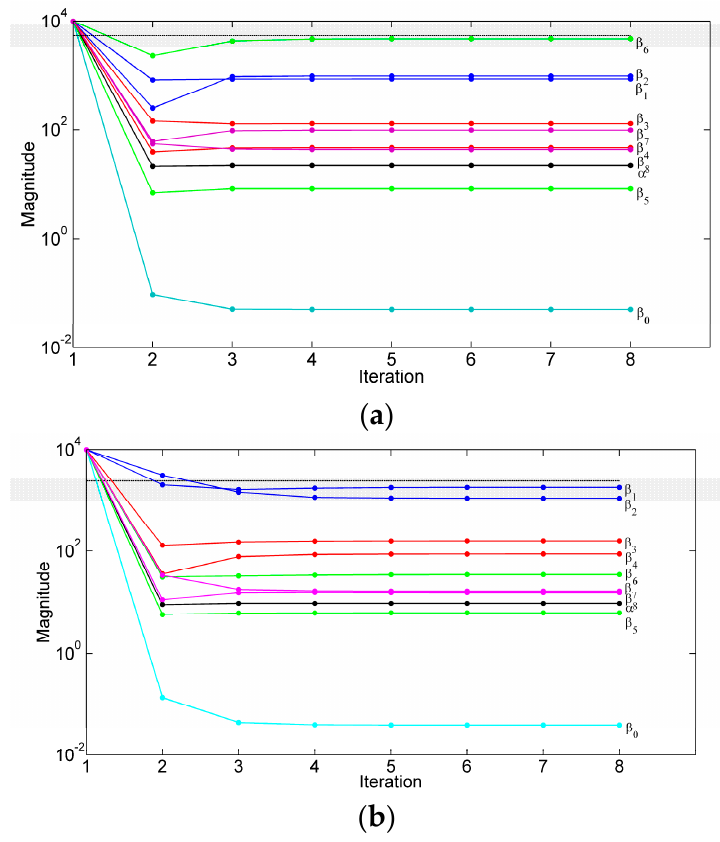
Figure 4. Time plots of the hyperparameters: ( a ) TW dataset; and ( b ) OW dataset. The priors of the stride time and stance duration were given precisions β 1 and β 2 , respectively; the priors of the ML, AP and VT components of the shank acceleration were given precisions β 3 – β 4 , β 5 – β 6 and β 7 – β 8 , respectively; the Gaussian noise in the likelihood function was given precision α . The threshold for pruning the i -th column of the design matrix is depicted using the horizontal line in black.